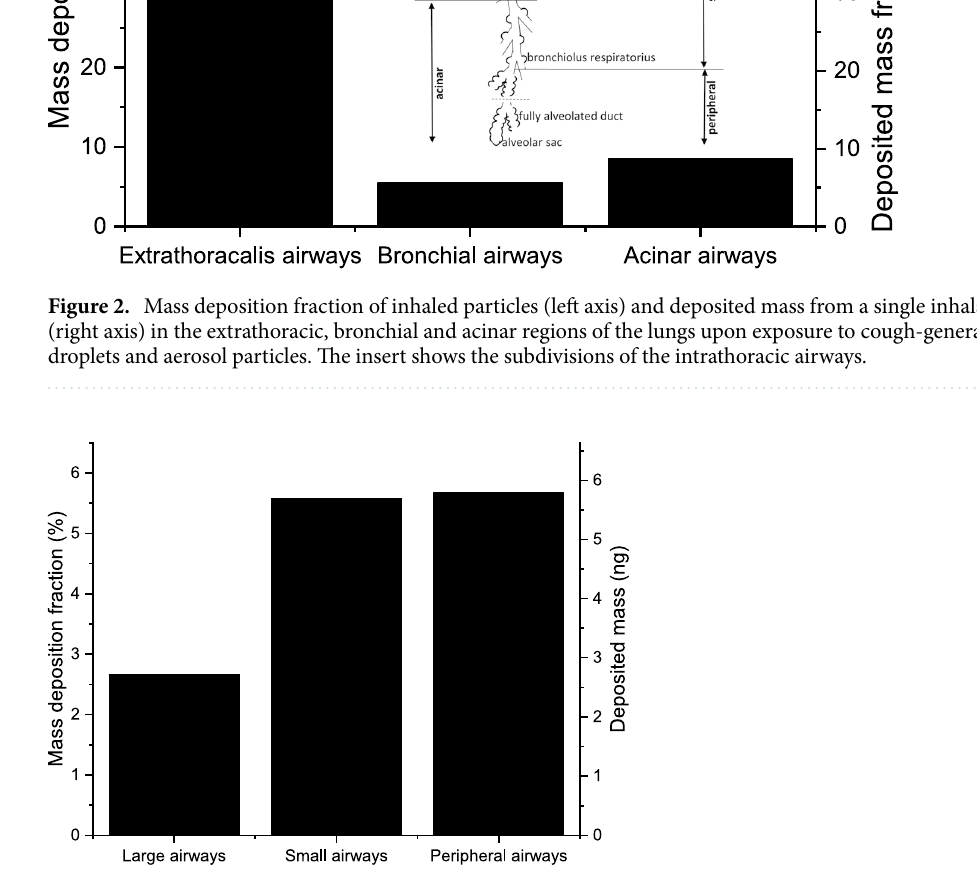
Figure 3. Mass deposition fraction of inhaled particles (left axis) and deposited mass from a single inhalation (right axis) in the large, small, and peripheral airways upon exposure to cough-generated droplets and aerosol particles. See also the insert in Fig. 2 for the definitions of large, small, and peripheral